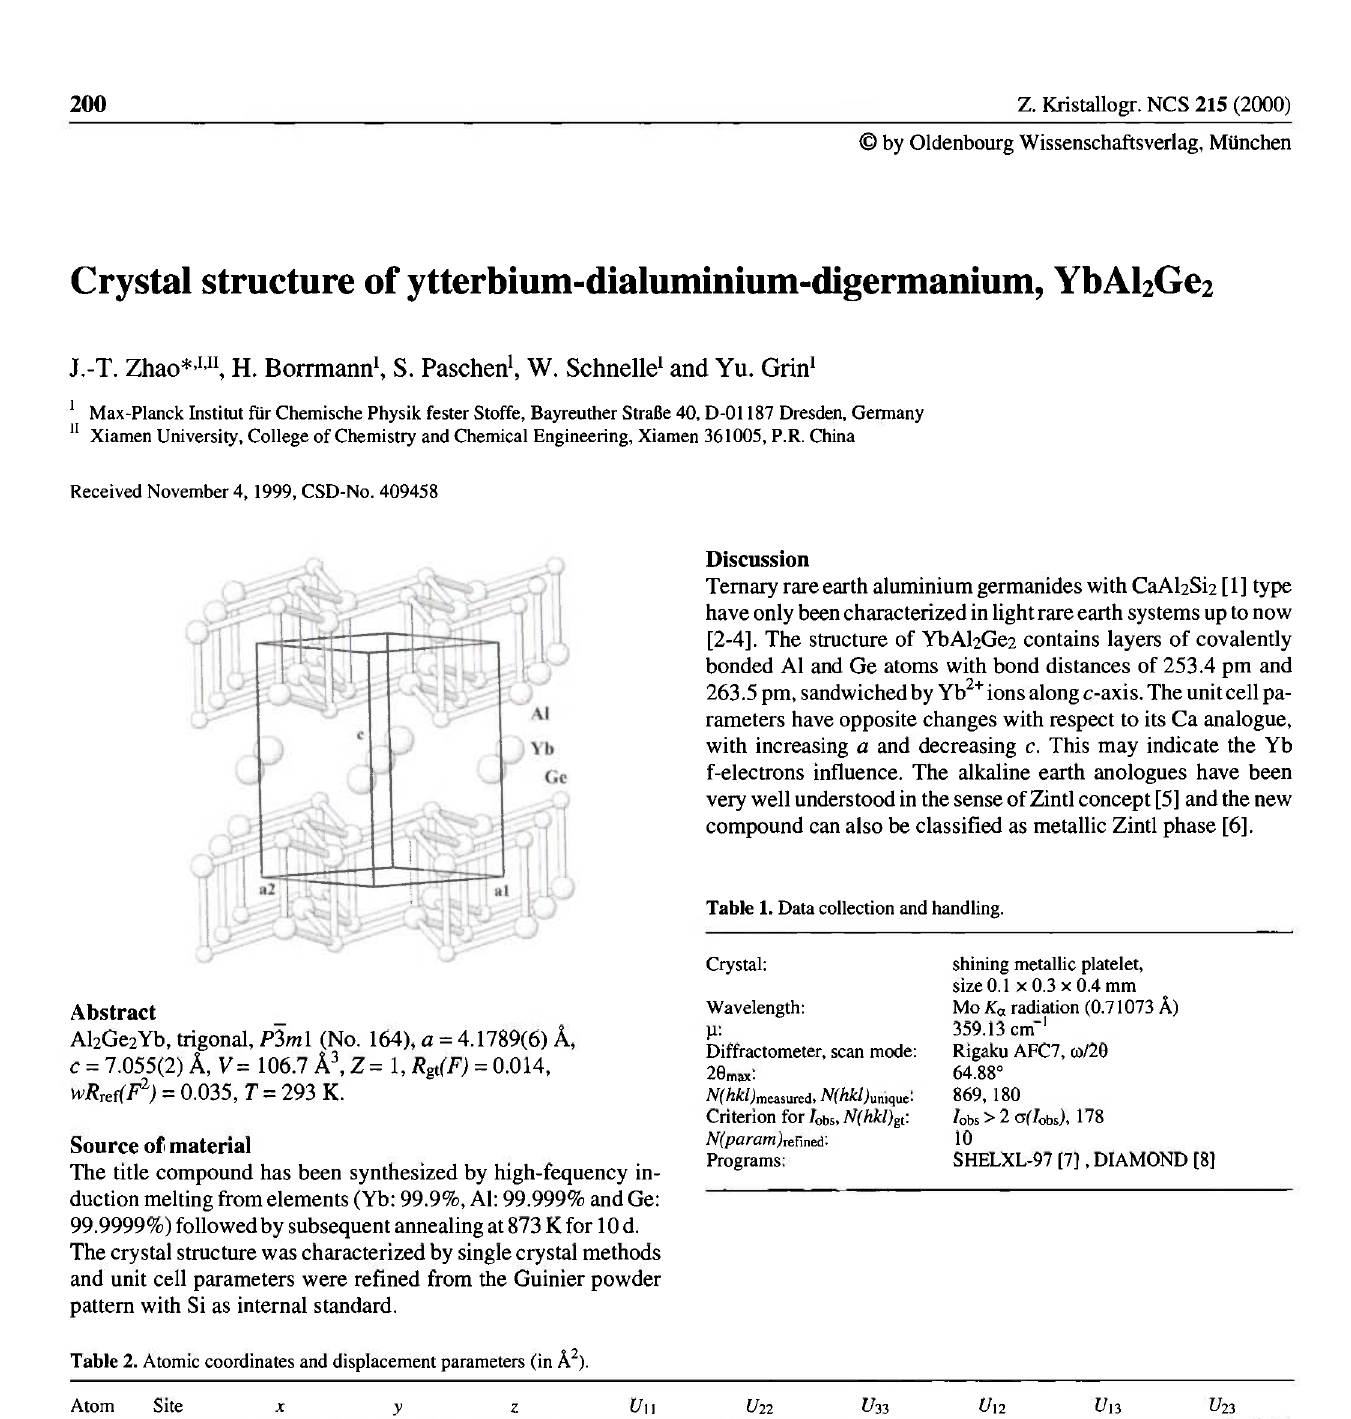
Table 2. Atomic coordinates and displacement parameters (in Ä 2 ).